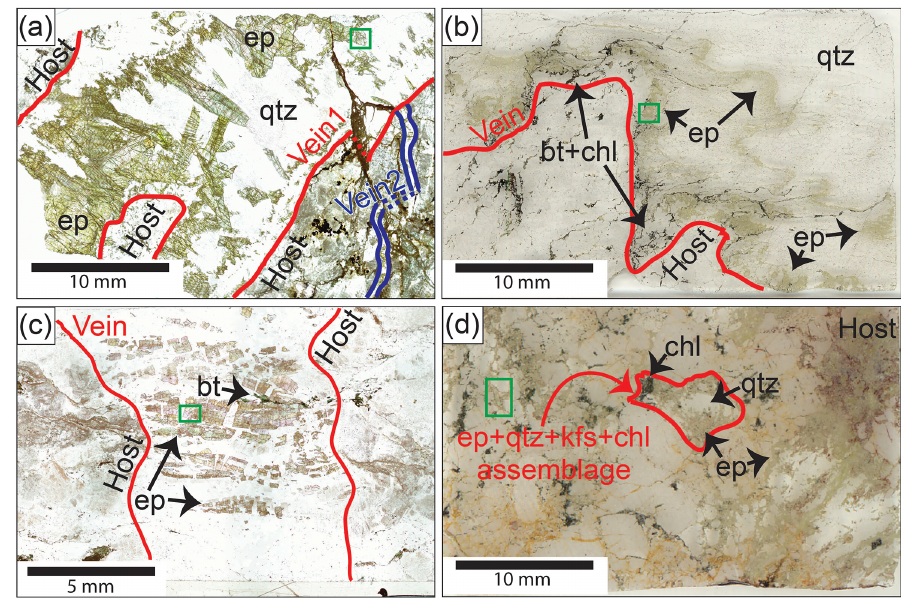
Figure 1. Scans of thin sections of (a) Albula-1, (b) Grimsel-1, (c) Grimsel-2, and (d) Heyuan-1 samples. (a, b) Plane-polarized light on petrographic microscope; (c, d) plane light. Green rectangles indicate the location of the BSE images shown in Fig. 2. bt: biotite; chl: chlorite; ep: epidote; kfs: K-feldspar; plg: plagioclase; qtz: quartz.